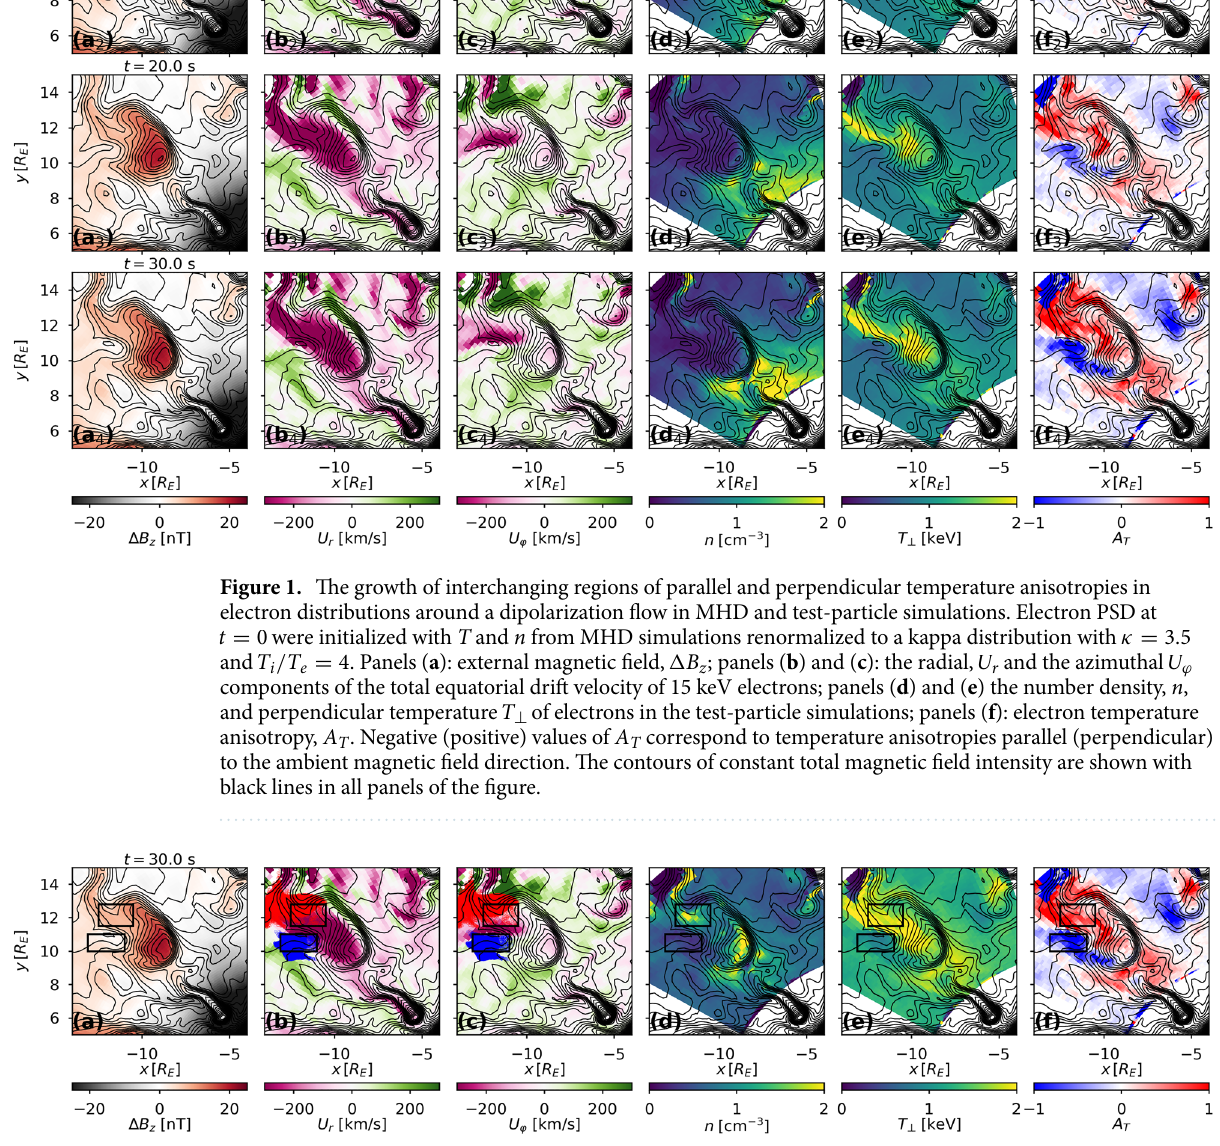
1 keV, and 3.5 , T e = =